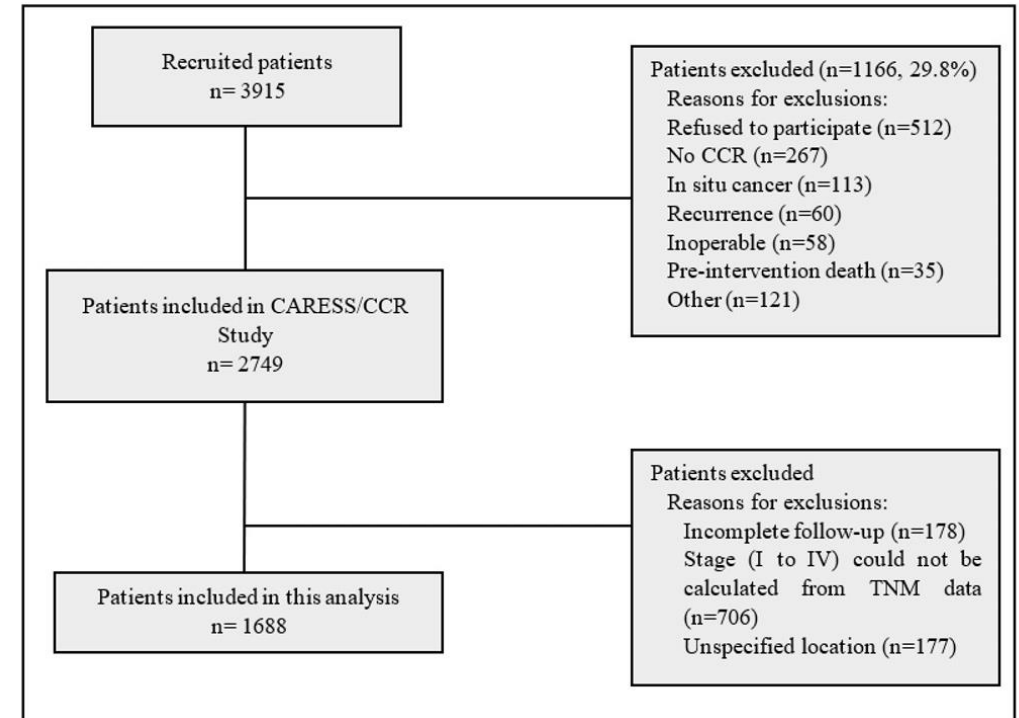
Figure 1. Flowchart summarizing the inclusion and exclusion criteria applied.